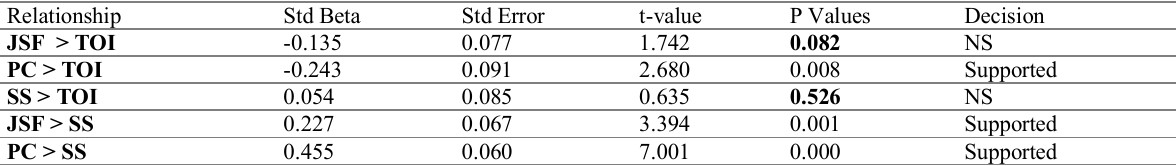
Tabel 5: Results of the structural model analysis.